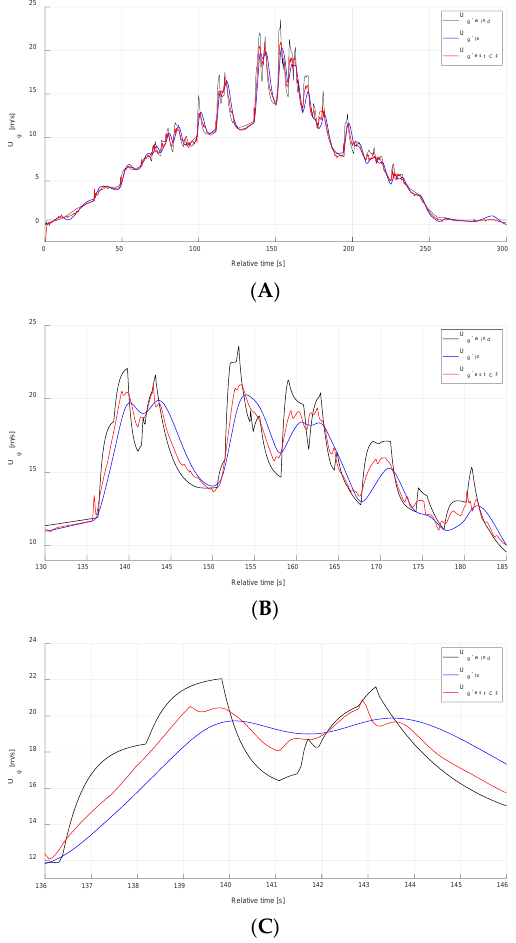
Figure 17. Comparison of the gust value with the estimation results (complementary filter, T c = 0.5 s, estimation delay reduced by 1 s)—flight crossing a gust area; ( A ) whole simulation, ( B ) several selected gusts, and ( C ) single selected gust.